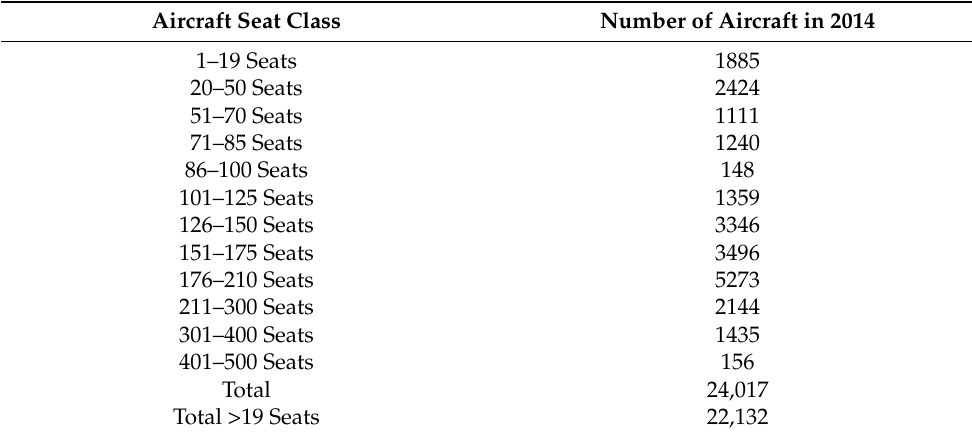
Table 1. The 2014 base year aircraft fleet by seat